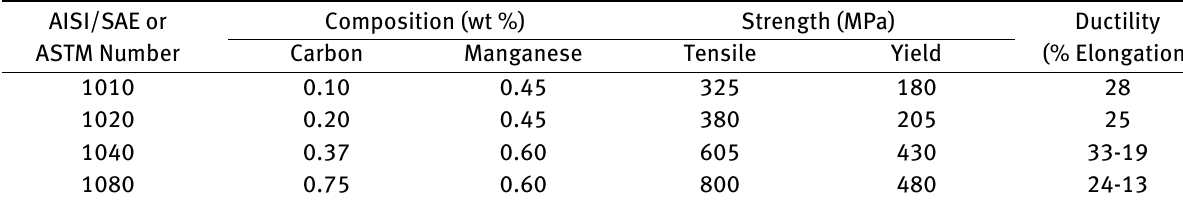
Table 1: Chemical composition and mechanical properties for proposed materials [21–27].